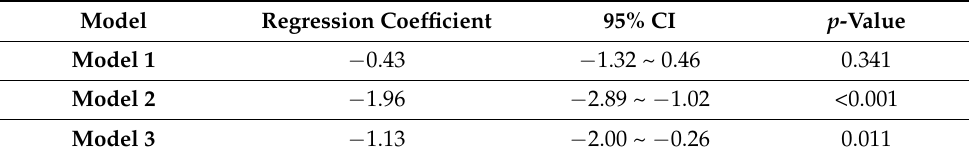
Table 2. Multivariate analysis for DQI-I associated with CCVD.